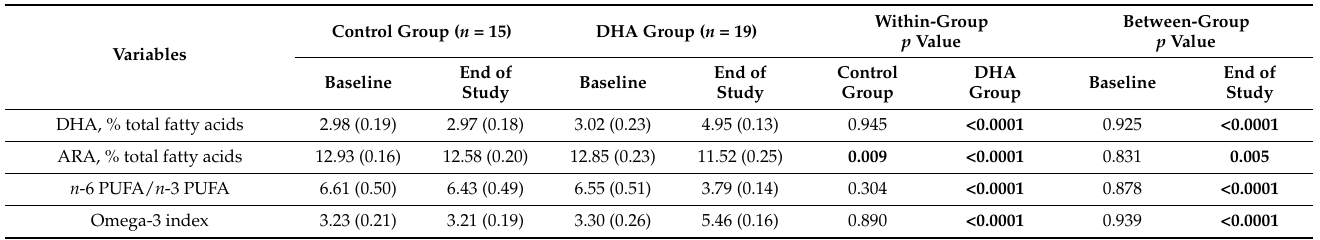
Table 3. Lipidomic variables at baseline and at the end of the study in patients treated with the DHA supplement and in controls.